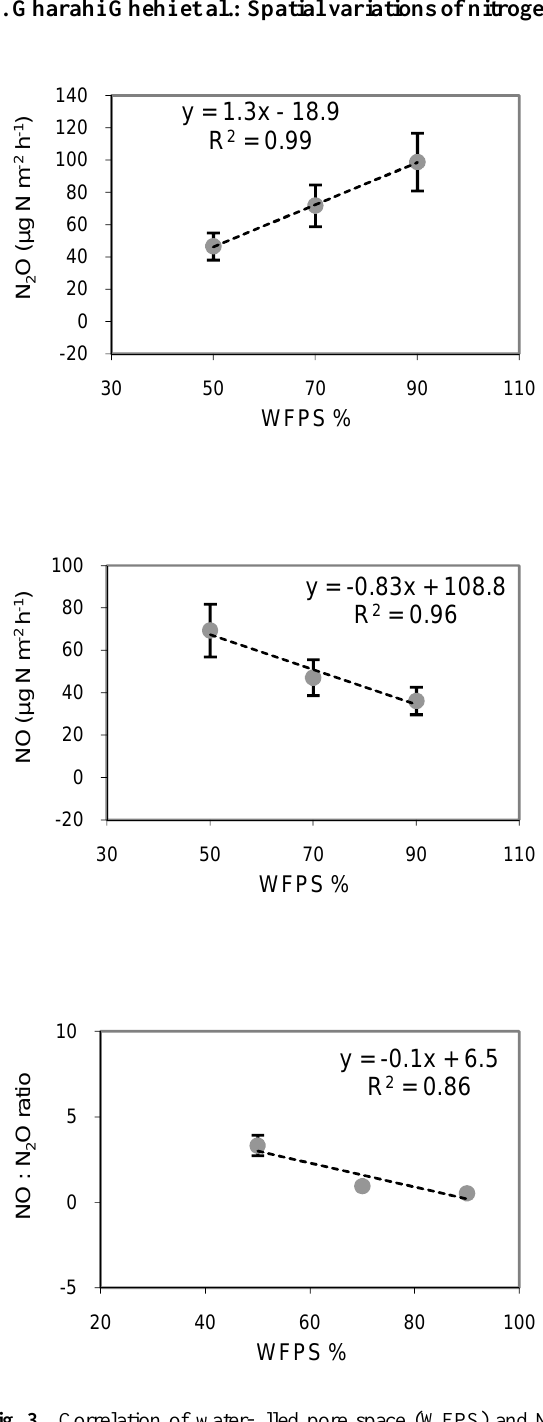
Fig. 3. Correlation of water-filled pore space (WFPS) and N 2 O, NO emission rates and NO:N 2 O ratio (mean of 31 sites, error bars indicate plus minus standard